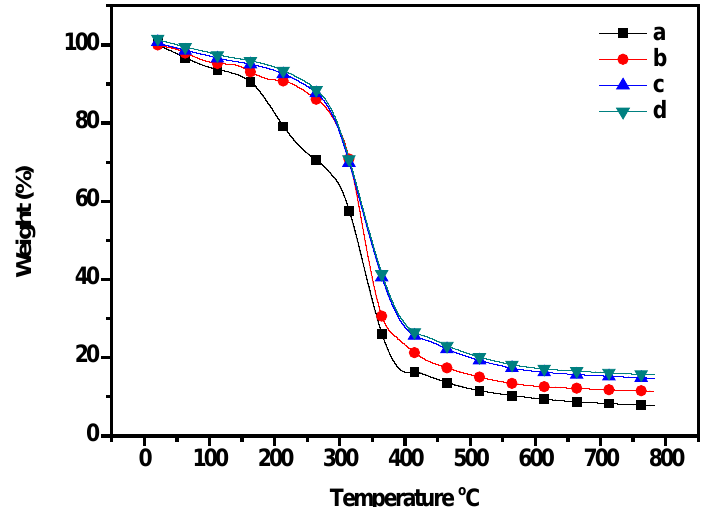
Figure 4. TGA curves of composites having: ( a ) only CP, ( b ) 1:0.5 CP/PU, ( c ) 1:1 CP/PU, and ( d ) 1:1 CP/PU with 10 wt% curcumin. Table 2. Thermal properties, mechanical properties, WVP, and CA of the CP/PU/curcumin compo- site films.